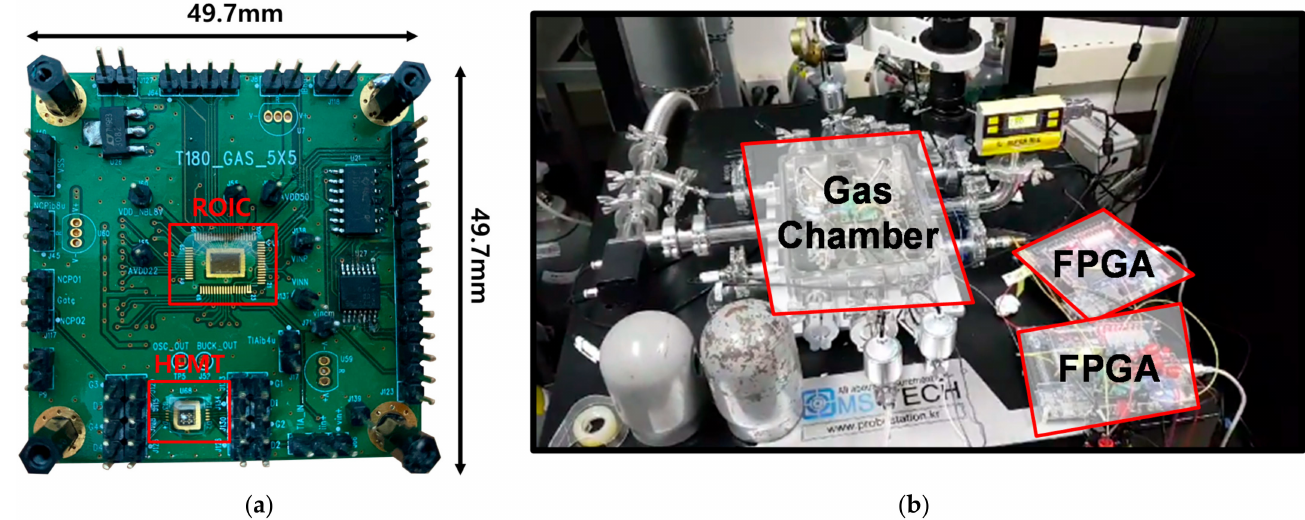
Figure 24. ( a ) Prototype PCB; ( b ) prototype test setup.